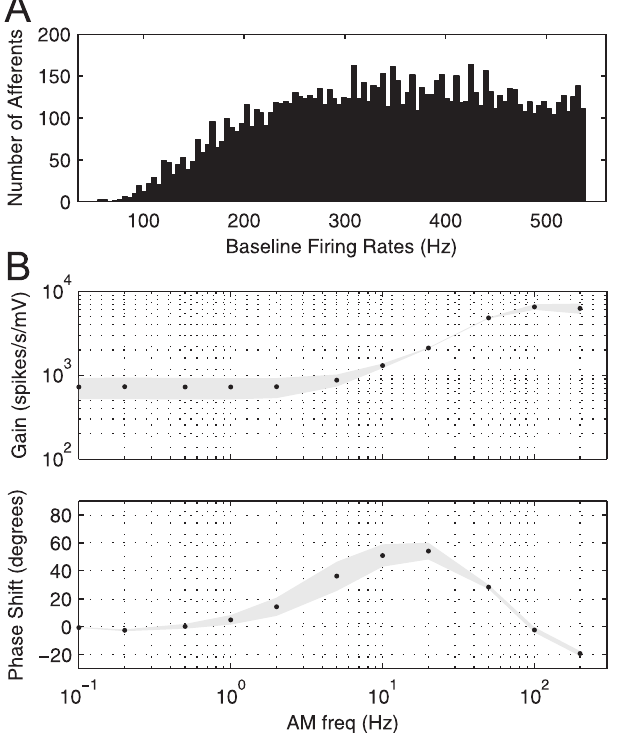
Figure 9. Gain, Phase Response, and Firing Rate Distribution for Afferent Model (A) Histogram displaying baseline (2 s, no stimulus) firing rate distribution for modeled afferents ( N ¼ 10,000). Mean firing rate is 0.34 6 0.11 kHz, similar to 0.33 6 0.13 kHz measured in vivo [53]. (B) Gain and phase response of modeled P-type afferents ( N ¼ 5) (minimal change for larger groups) for 20-s sinusoidal stimuli. Frequencies range from 0.1 to 200 Hz. Black dots indicate mean values, gray areas depict one standard deviation. Profiles are similar to [21] for simulations and